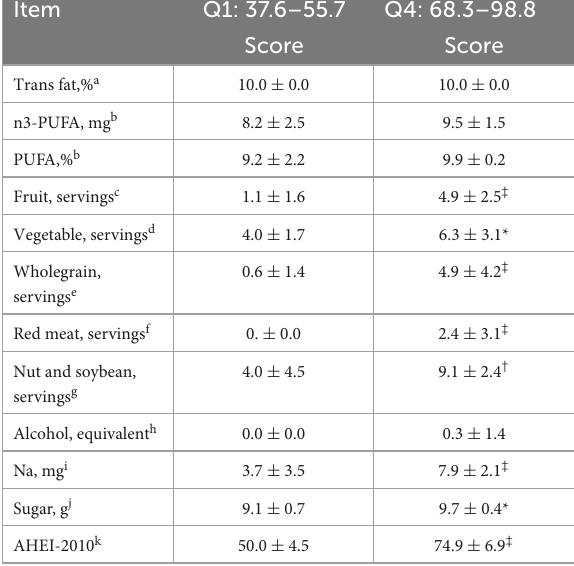
TABLE 3 Comparison of components and scores between the lowest and the highest quartiles of AHEI-2010 dietary scores 1